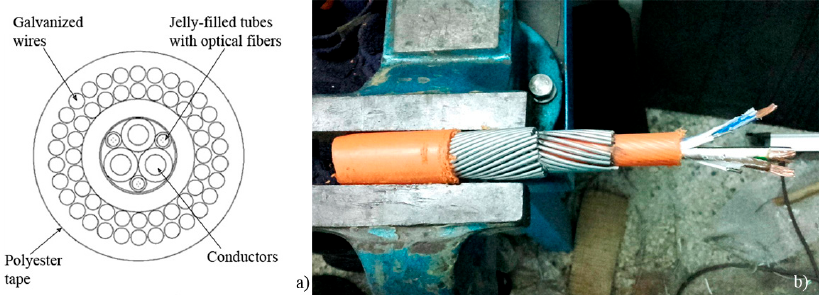
Figure 2. ( a ) Sketch of the cable section and ( b ) split of cable with external galvanized wires and internal optical cables and conductors.